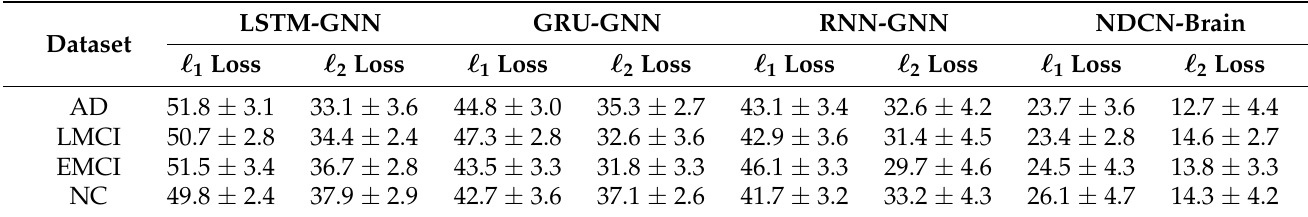
Table 2. The (cid:96) 1 loss and (cid:96) 2 loss comparison results of in-snapshots.